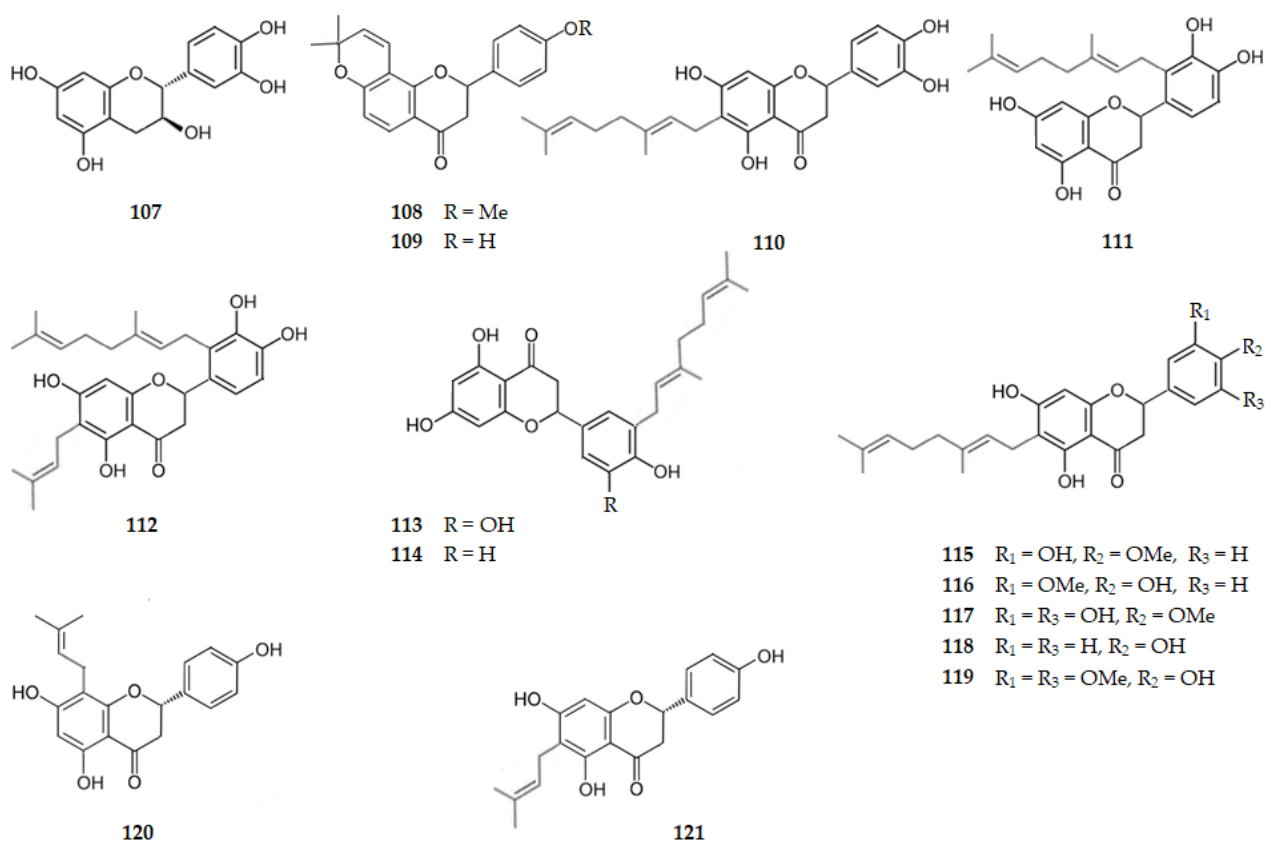
Figure 11. Structure of some of the catechins and flavanones that inhibit AChE and of the inactive flavanones 109 , 120 and 121 .